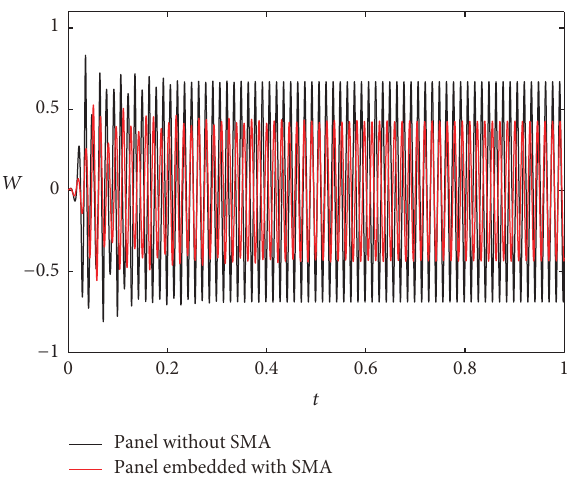
Figure 15: Curves of 𝜆 cr versus 𝑇 with various 𝑉 𝑠